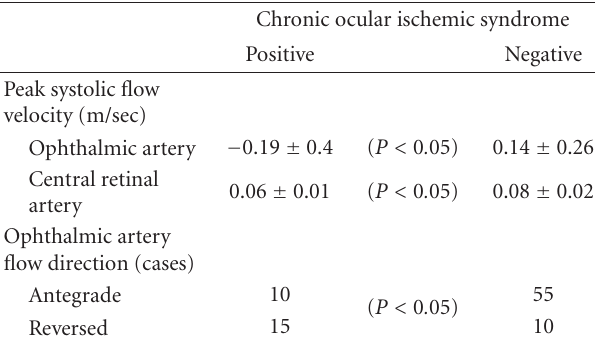
Table 2: Relationship between chronic ocular ischemic syndrome and ocular